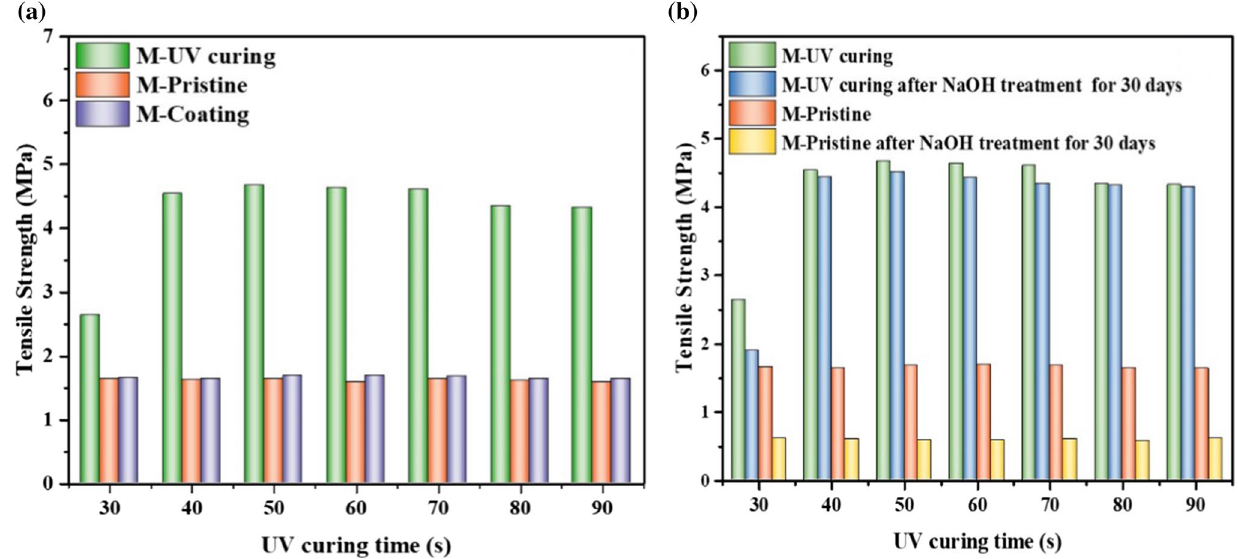
Fig. 4 a Effect of UV-curable resin-modified PVDF membrane on tensile strength (there is no relationship between the UV curing time of abscissa and M-Pristine and M-coating). b Effect of NaOH (pH = 13) treatment on pristine PVDF membrane and UV resin cured